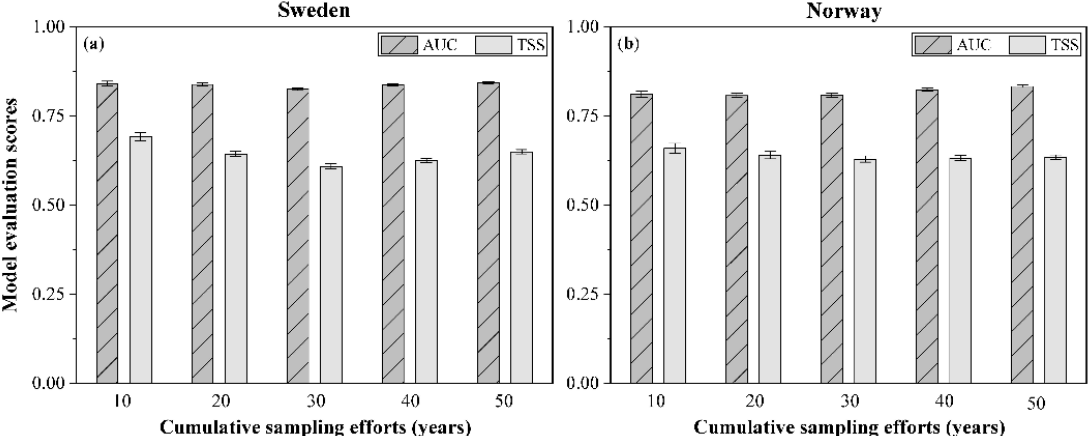
Figure 5. Mean value of the area under the receiver–operating characteristic curve (AUC) and the true